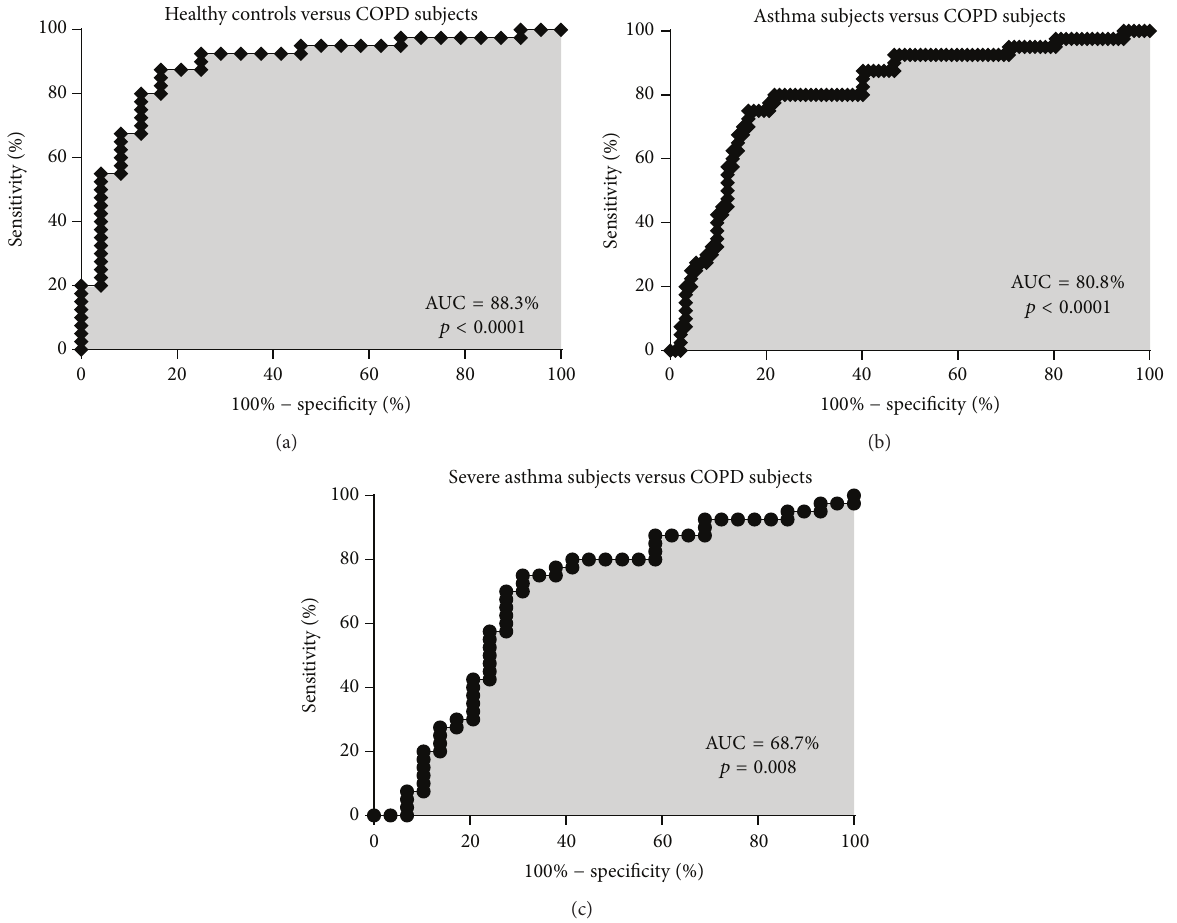
Figure 5: 𝛽 -defensin-1 as a biomarker. Airway expression of 𝛽 -defensin-1 can distinguish COPD from (a) healthy controls, (b) asthma patients, and (c) severe asthma patients.